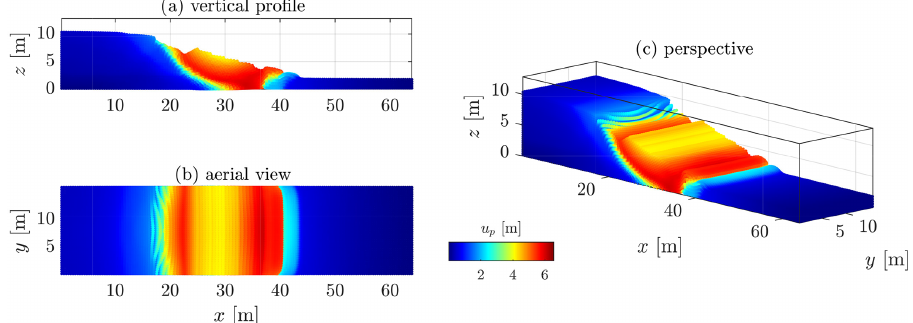
Figure 19. Displacement field obtained after t = 15s for a homogeneous peak cohesion field. One can see an overall homogenous displace- ment field with some of the first-order characteristics of a slump, i.e. a rotational displacement with a compression zone at the toe, a transition zone delimited by one principal shear zone and a major scarp at the top of the